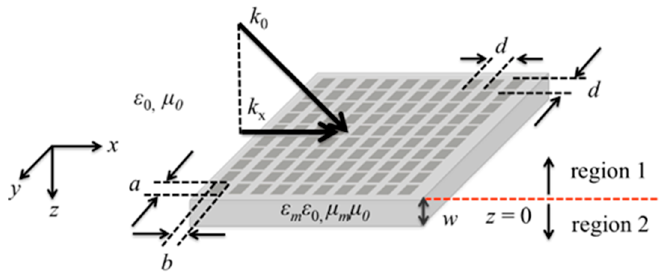
Figure 1. The theoretical model of the metal hole array (MHA) with TM incident waves. Region 1 is the space above the MHA. Region 2 is the space in the holes of the MHA.